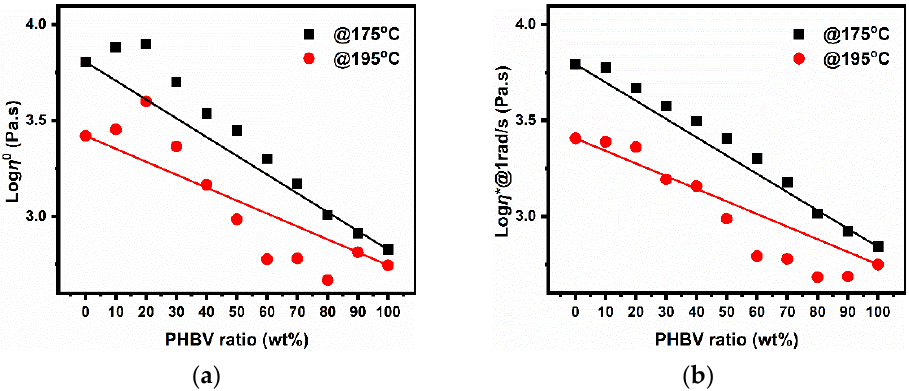
Figure 11. Plots of ( a ) zero-shear viscosity and ( b ) complex viscosity at 1 rad/s versus PHBV composition as a function of in PLA/PHBV blends at 175 °C and 195 °C (the points represent the experimental values, whereas the black and red lines were predicted using the logarithmic additivity rule at these temperatures).